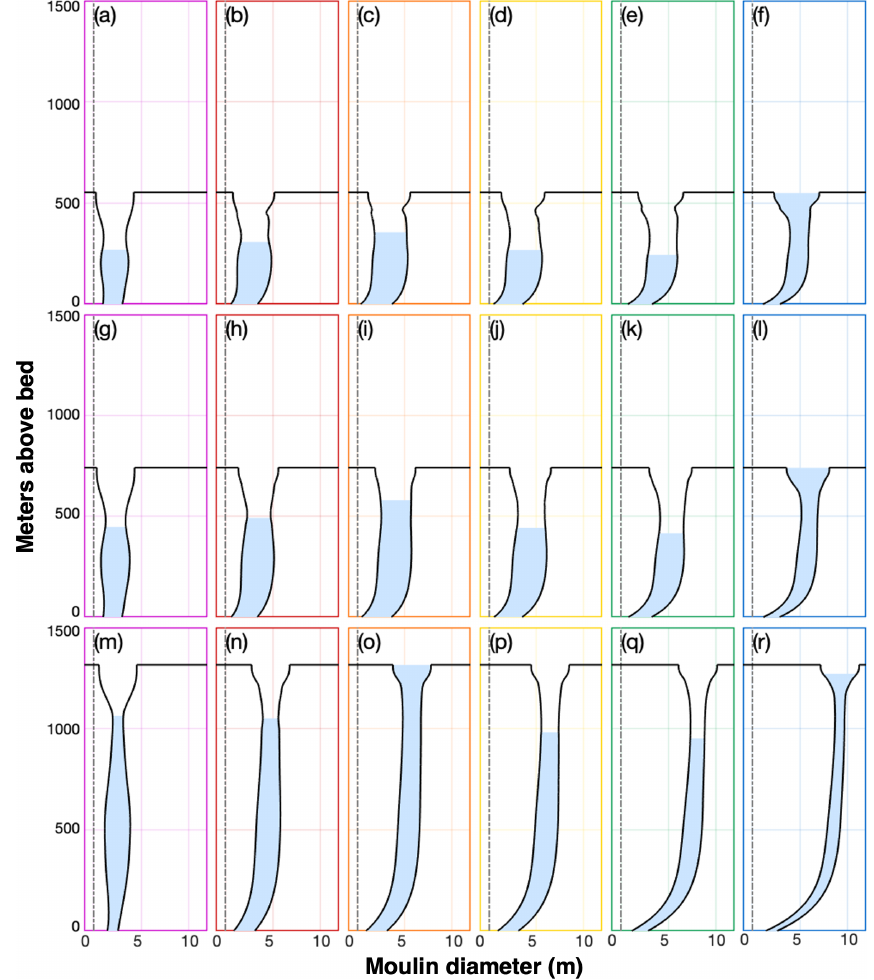
Figure 7. Evolution of moulin geometry over the melt season. Colored boxes correspond to the times indicated with colored vertical lines in Fig. 6. (a–f) Basin 1 with ice thickness of 553m. (g–l) Basin 2 with ice thickness of 741m. (m–r) Basin 3 with ice thickness of 1315m. Axes are not to